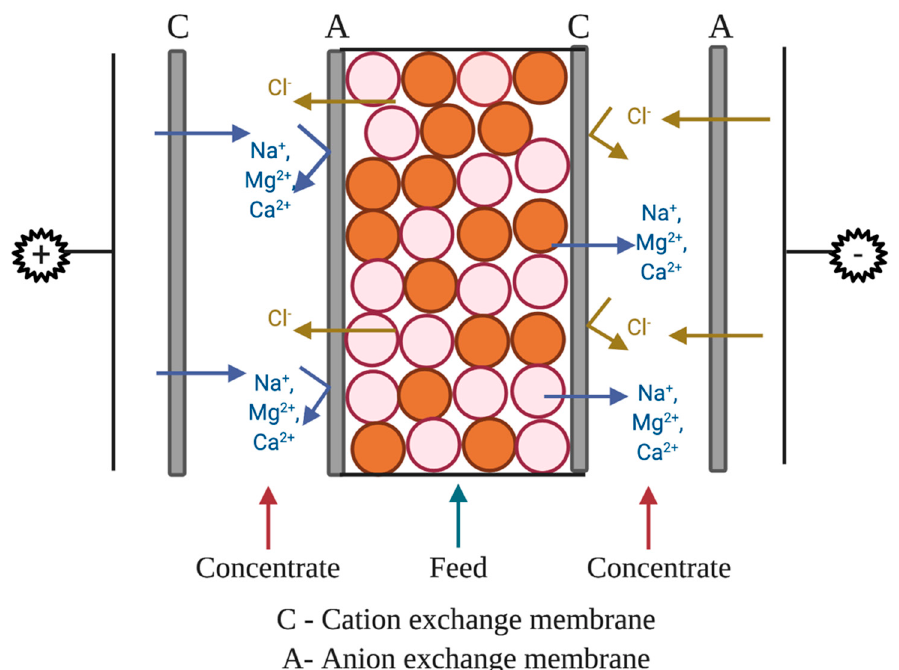
Figure 2. Illustration for wafer-enhanced electrodeionization (EDI) Figure 2 . Illustration for wafer-enhanced electrodeionization (EDI) setup.